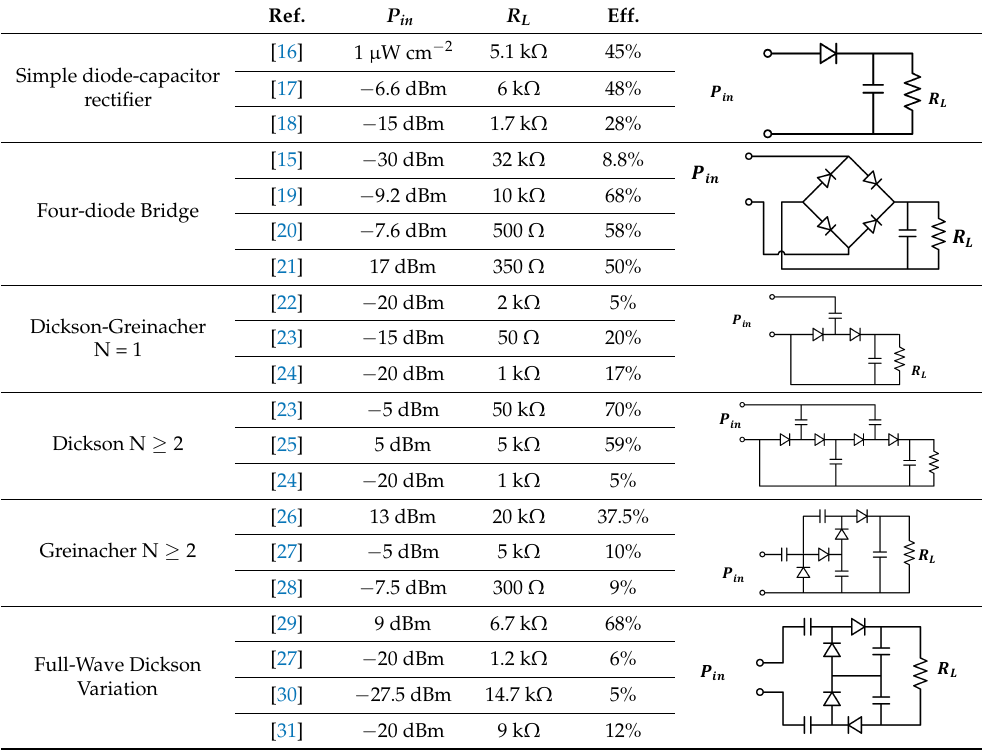
Table 1. Examples of common RF-Rectifier Circuits operating @ 2.45 GHz. Ref.